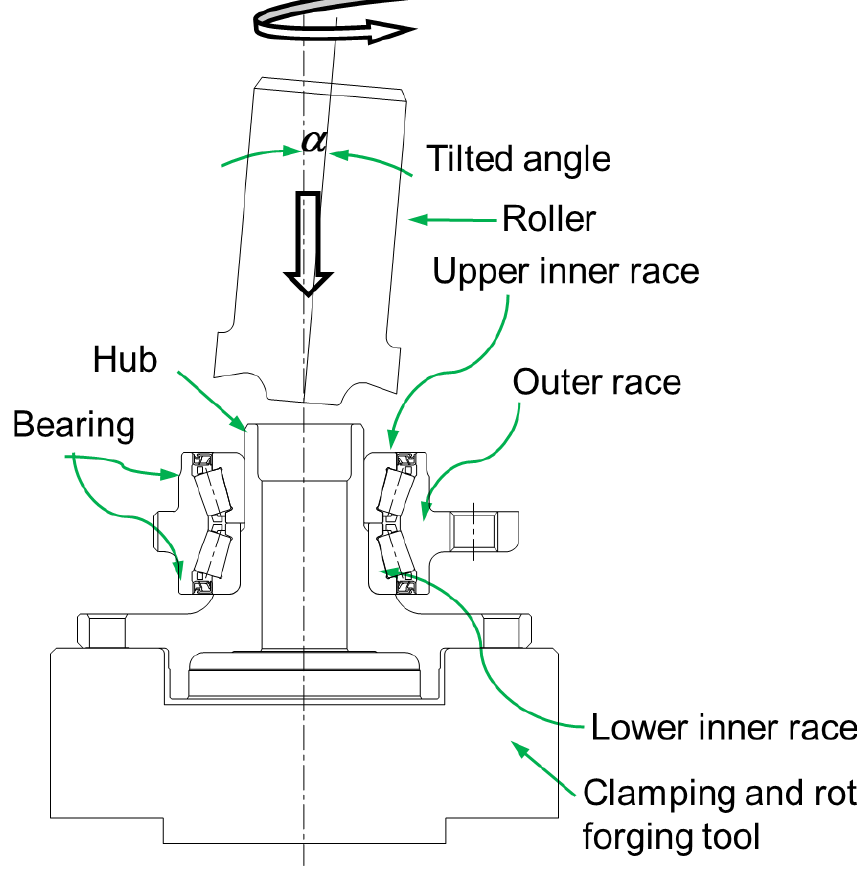
Figure 2. Schematic of the process.